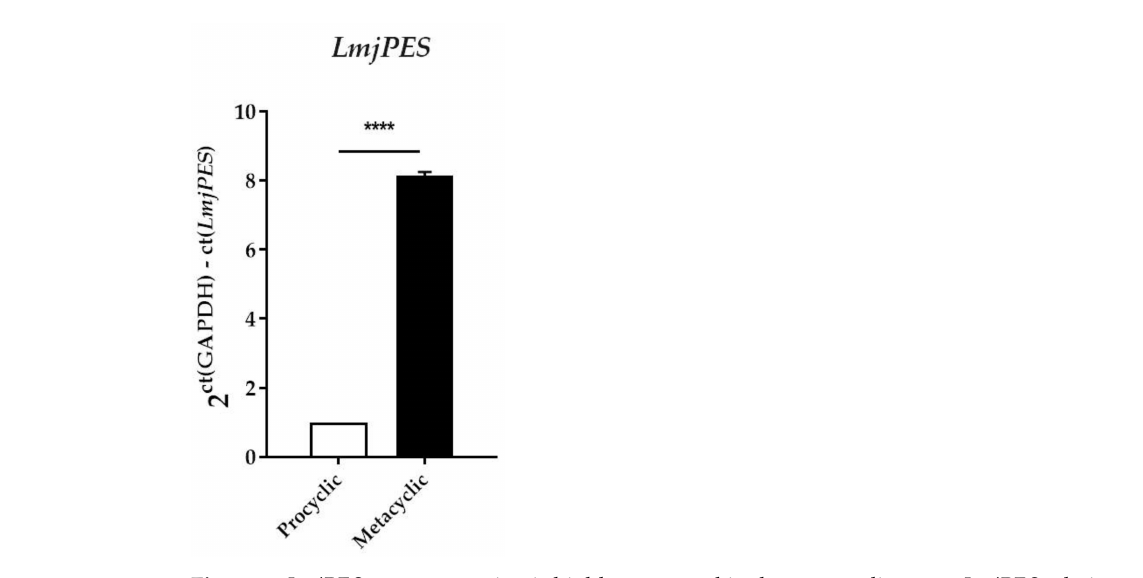
Figure 3. LmjPES gene expression is highly expressed in the metacyclic stage. LmjPES relative gene expression in procyclic and metacyclic promastigotes from Leishmania major . Bars represent gene